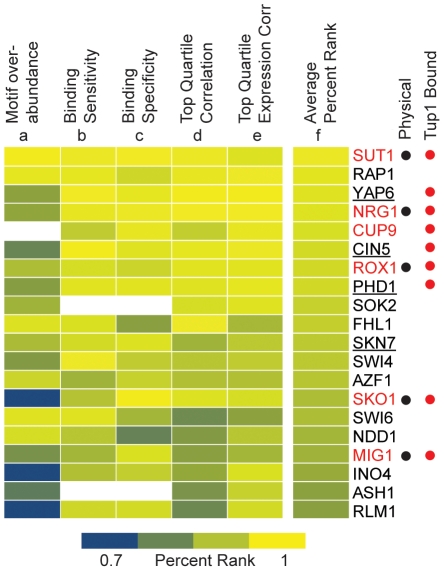
Prediction of novel Tup1 recruiters.Tup1 binding data was compared to ChIP-chip data from 204 transcription factors [30], [31] and tup1Δ expression data [7] using five tests (see text and Material and Methods for details). The percentile rank for each test and average percentile rank across all five tests is shown for the top 20 candidate transcription factors. Known Tup1 recruiting proteins are indicated by red text. Transcription factors previously shown to physically interact with Tup1 or Ssn6 are indicated with a black dot [57] and the transcription factors whose own promoters are bound by Tup1 are indicated by a red dot. Predicted Tup1 recruiters that were studied further are indicated with underlined text.